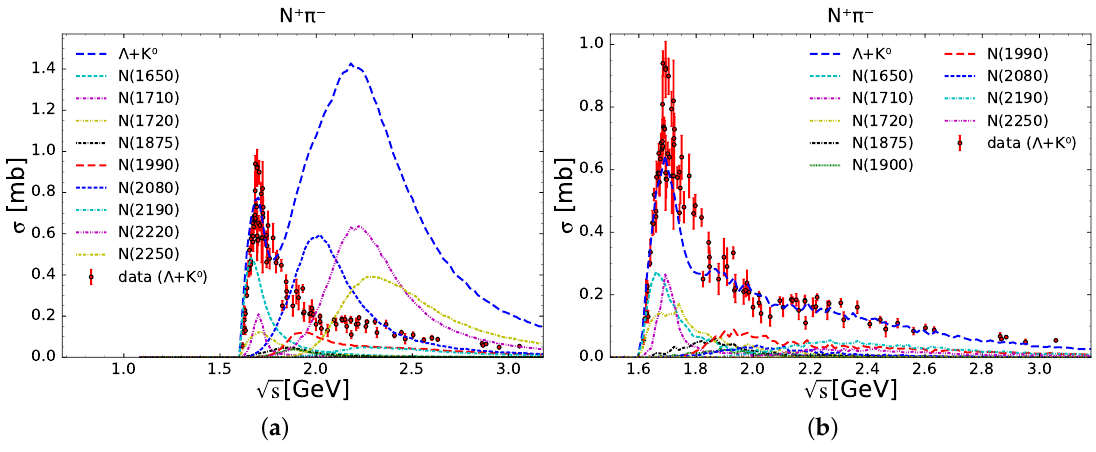
Figure 1. p π − → Λ K 0 cross section reconstructed from SMASH output (lines) compared to experimental data [11] (circles). ( a ) Using N ∗ branching ratios by choosing the middle of the range given by the PDG [7]. ( b ) After tuning the branching ratios to fit the experimental cross